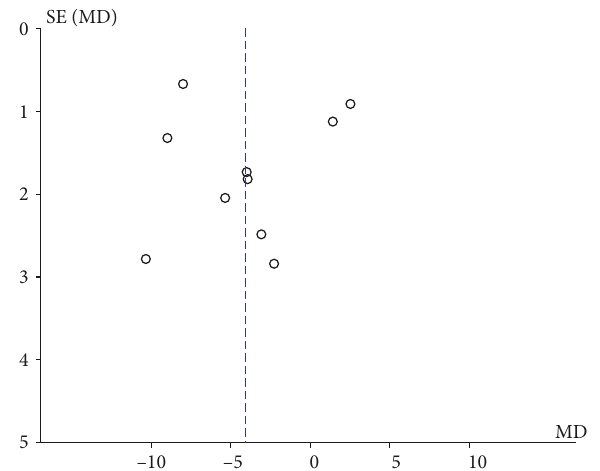
Figure 7: Funnel plot of included articles based on the data for